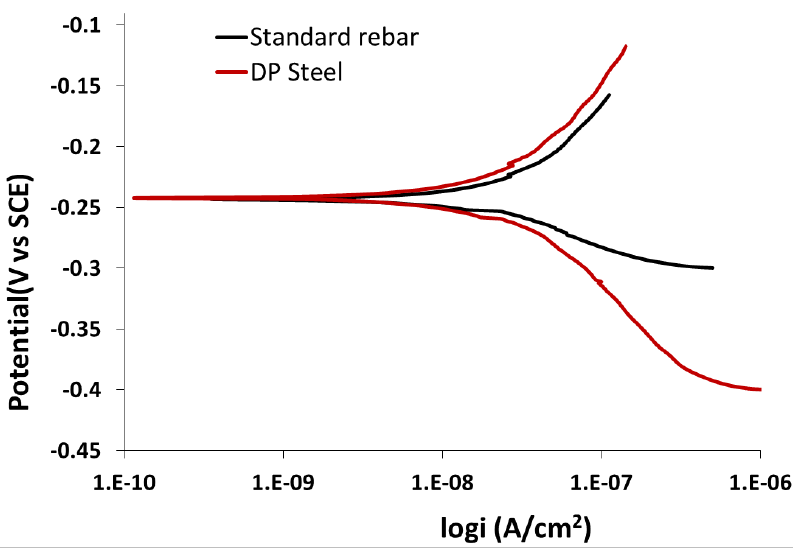
Figure 9. Potentiodynamic polarization results for standard rebar and DP steel in 0.3 M NaHCO 3 + 0.1 M Na 2 CO 3 (pH = 9.0)